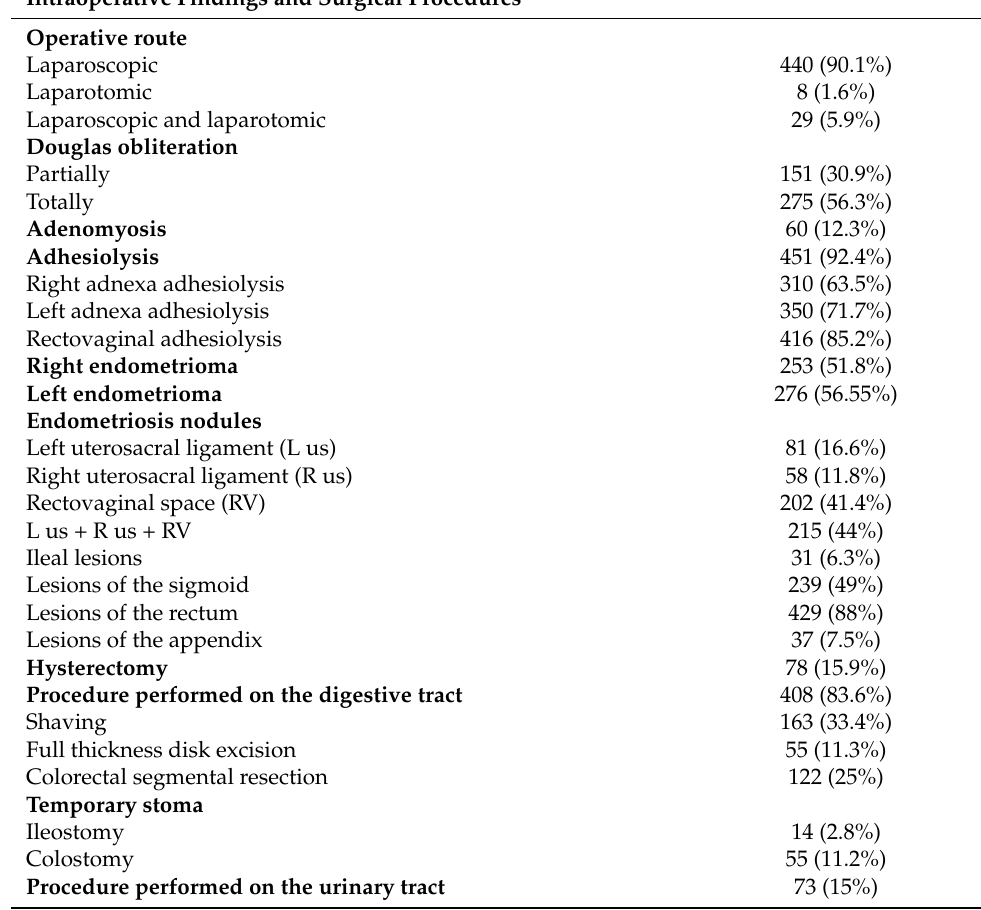
Table 2. Intraoperative findings and surgical